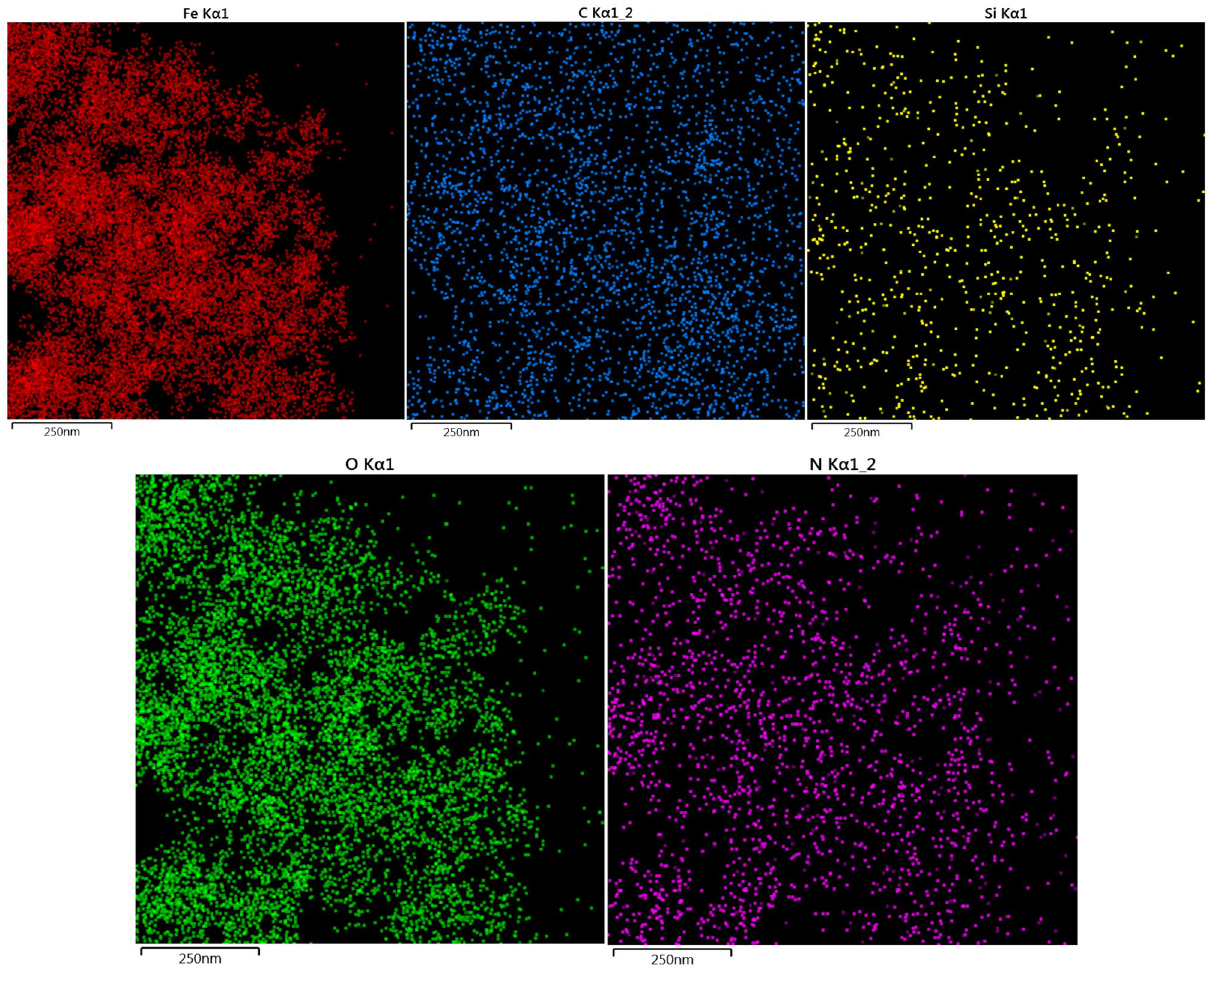
Figure 8. Elemental mapping of Ps@Tet@Fe 3 O 4